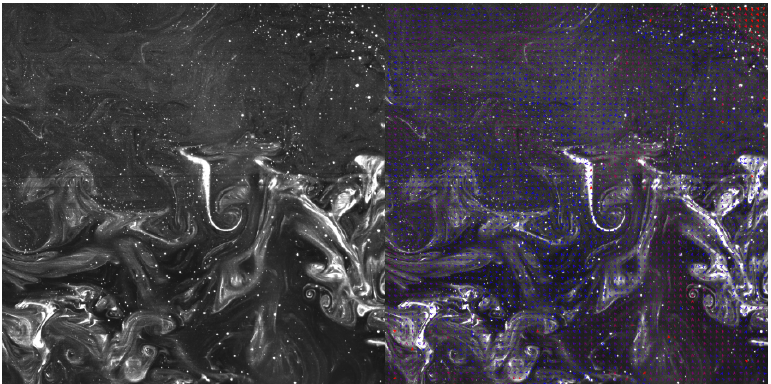
Figure 6. Typical videograms of water droplets in gas flow and trace particle velocity fields at droplet speeds U m = 2.5 m/s.